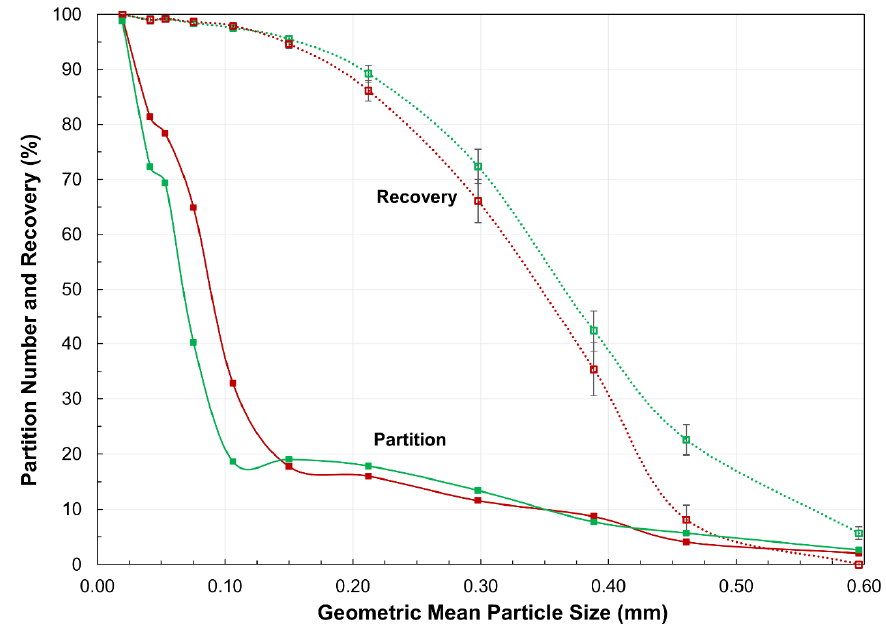
Figure 8. Partition-to-overflow product (filled squares and solid line) and copper recovery by size (unfilled squares and dotted line) for the best (green) and poorer (red) performing gas fluxes. Best performance had a gas flux of 0.15 cm/s, and poorer performance had a gas flux of 0.45 cm/s.